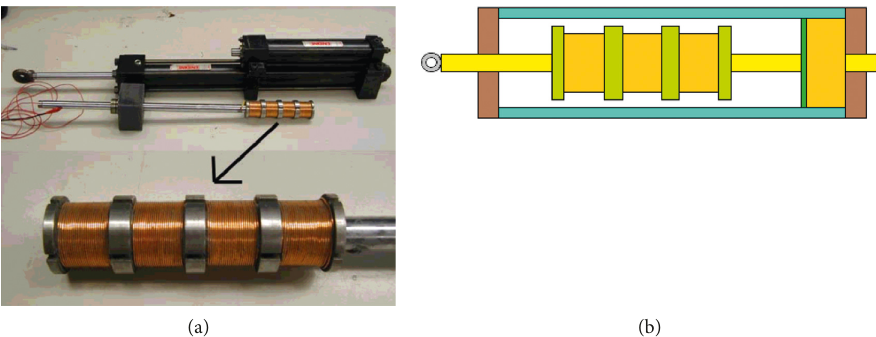
Figure 6: (a) Multicoil MR damper [44] and (b) diagram of multiple-coil MR damper